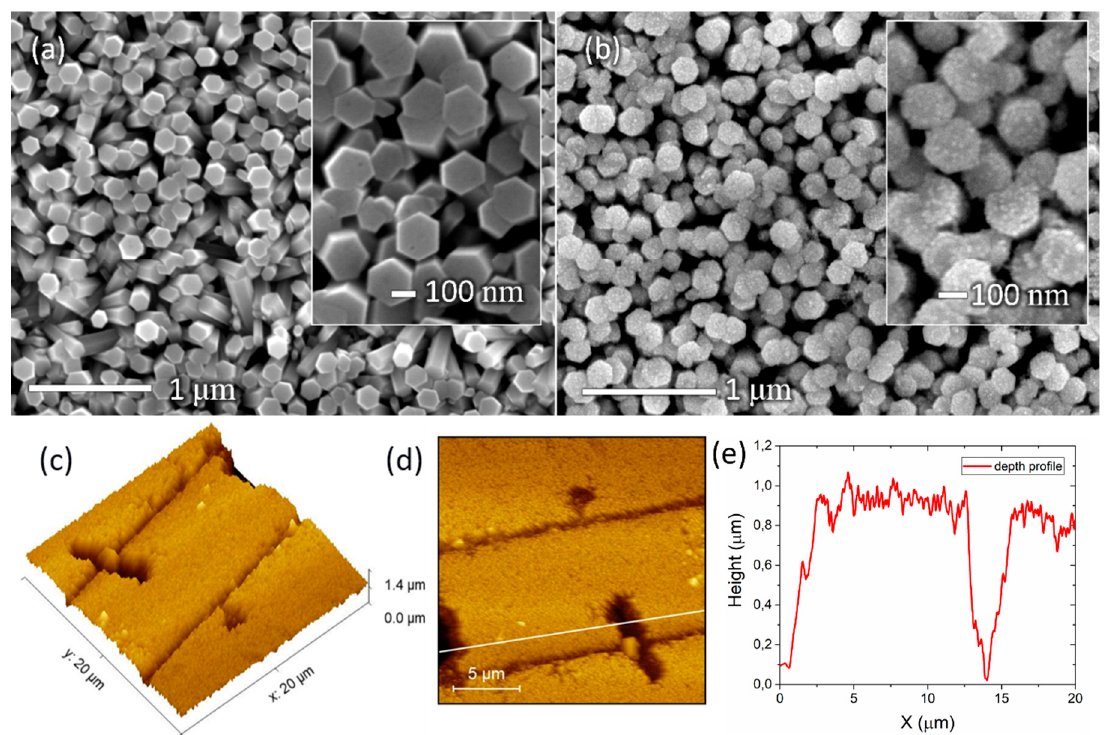
Figure 4 . Field emission scanning electron microscopy (FE-SEM) images of ( a ) bare ZnO NRs and ( b ) ZnO NRs/Au NPs with different magnifications. ( c , d ) A 3D AFM image for ZnO NRs and ( e ) depth profile of ~1 µm due to the limitation of tip size of AFM.